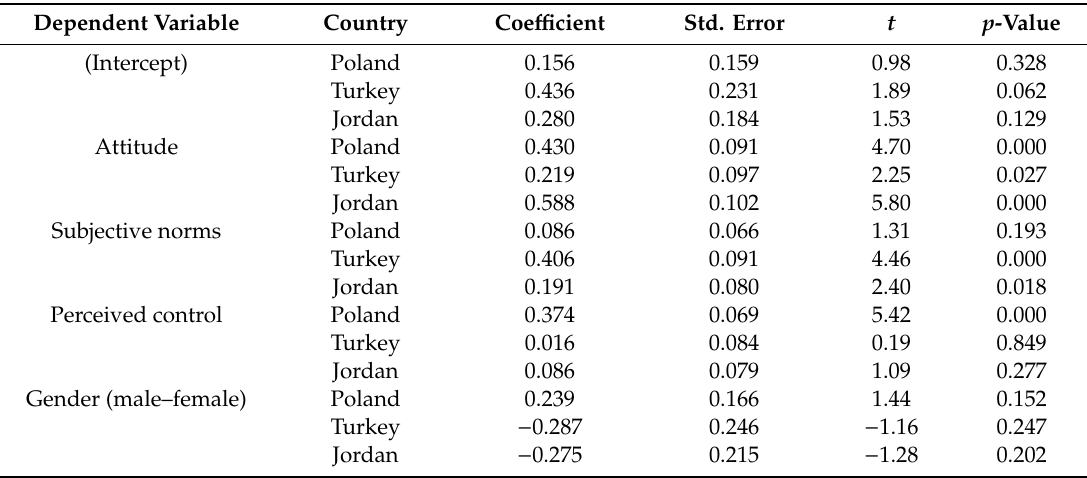
Table 3. Multiple regression results by country (dependent variable: behavioural